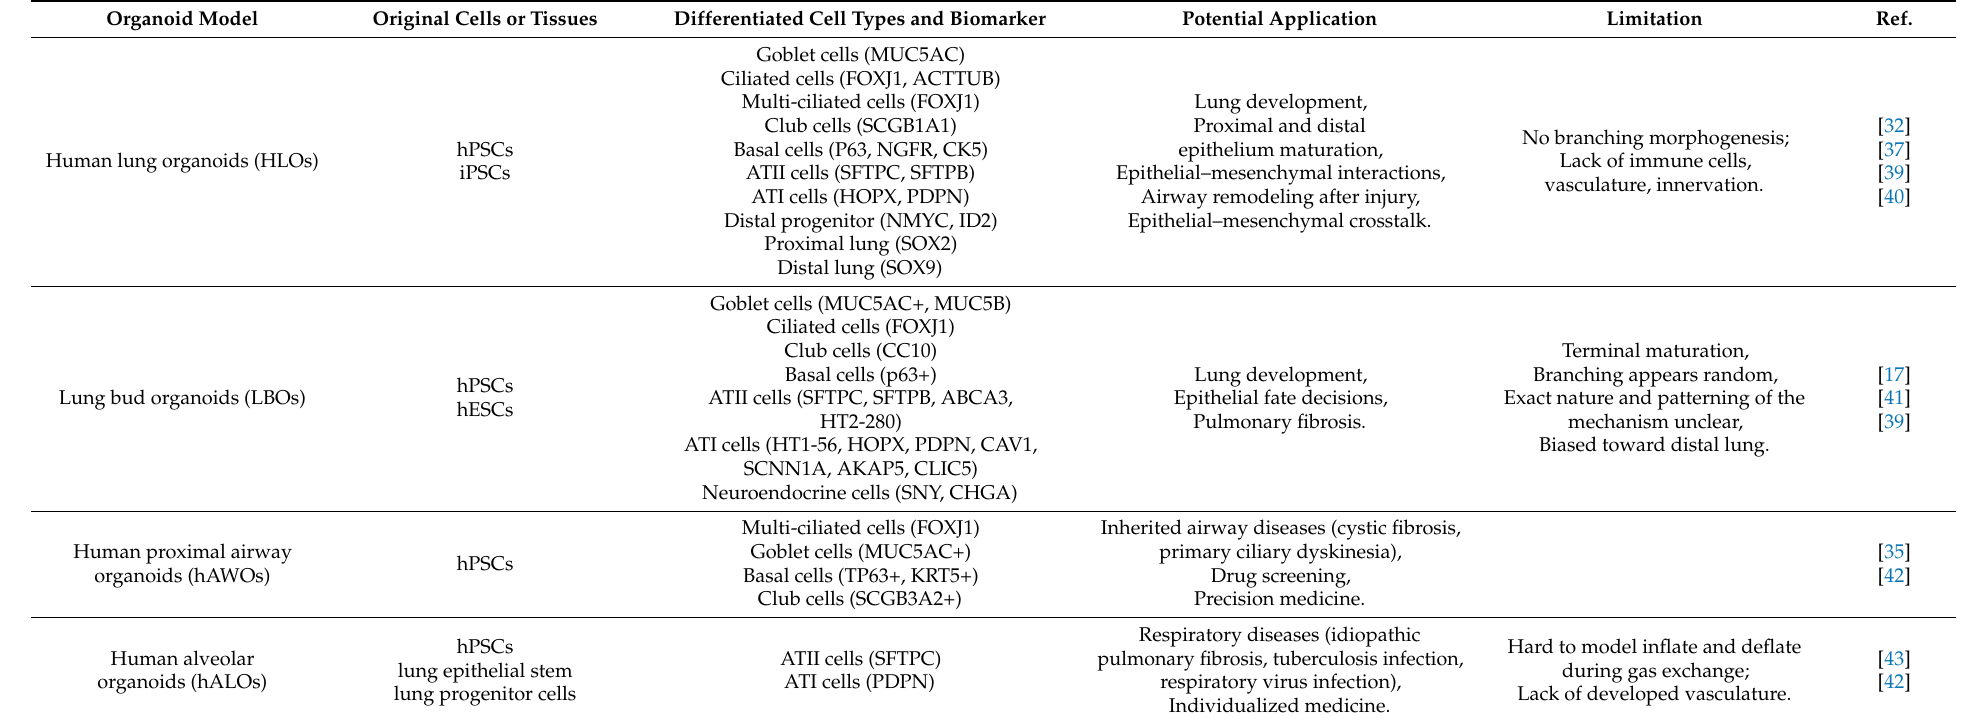
Table 1. Identification and application of existing lung